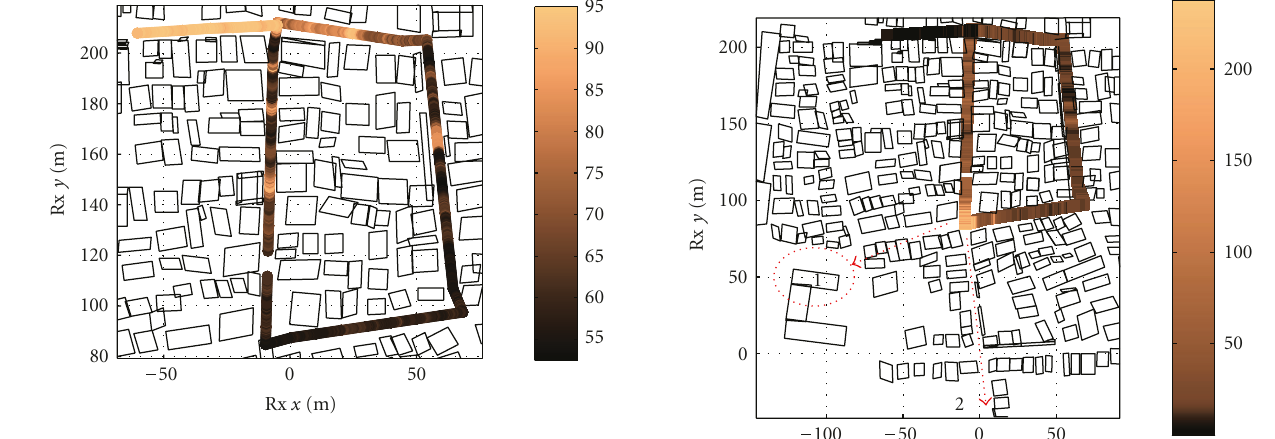
Figure 4: Specular power macrocell color-coded in %.